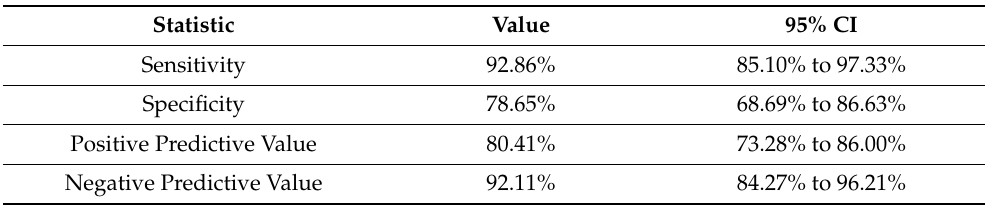
Table 4. Sensitivity, specificity, positive and negative predictive values of combined Gal-3 and HBME-1 with a 95% confidence interval